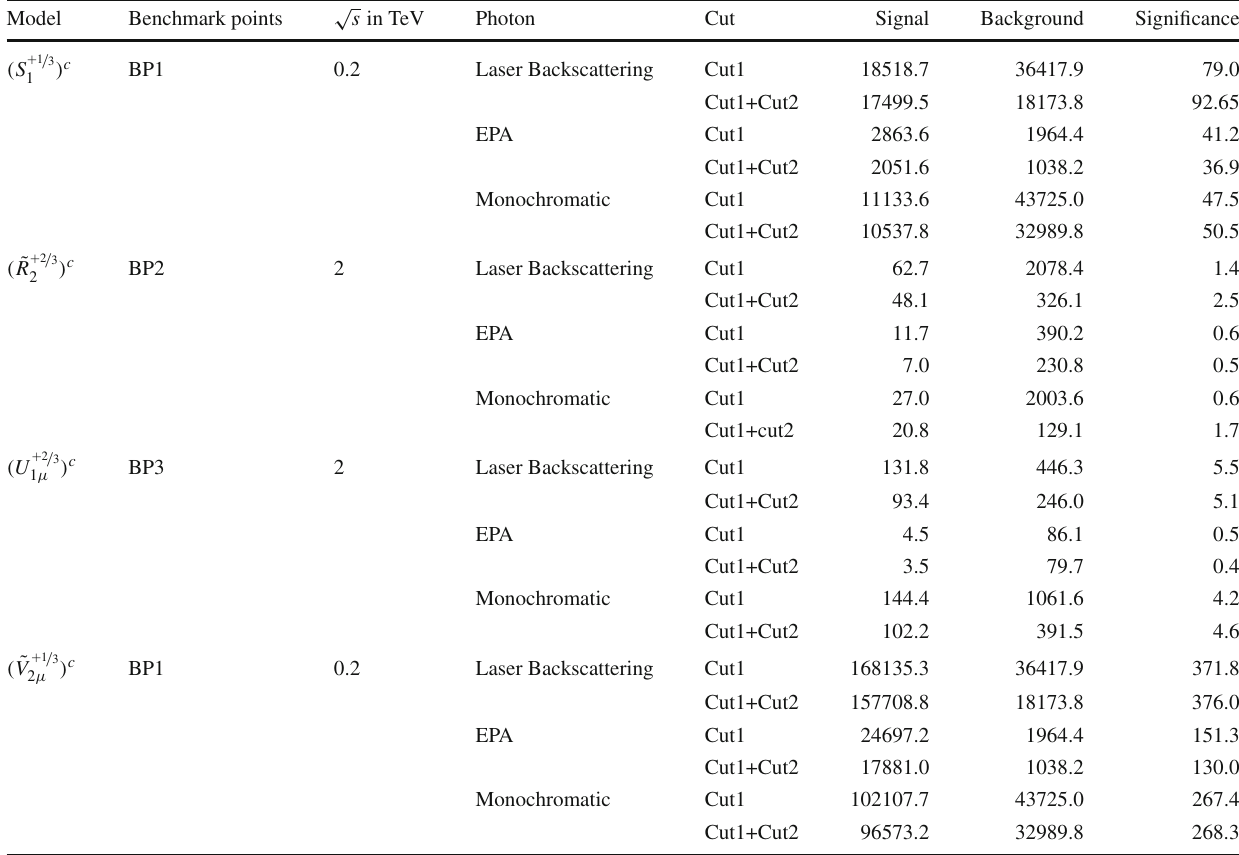
Table 15 Signal-background analysis for chosen four scenarios with laser backscattering, equivalent photon approximation and monochro- matic photon at e – γ collider of luminosity 100 fb − 1 . The term “cut1” indicates the invariant mass cut | M lj − M φ | ≤ 10 GeV whereas the term